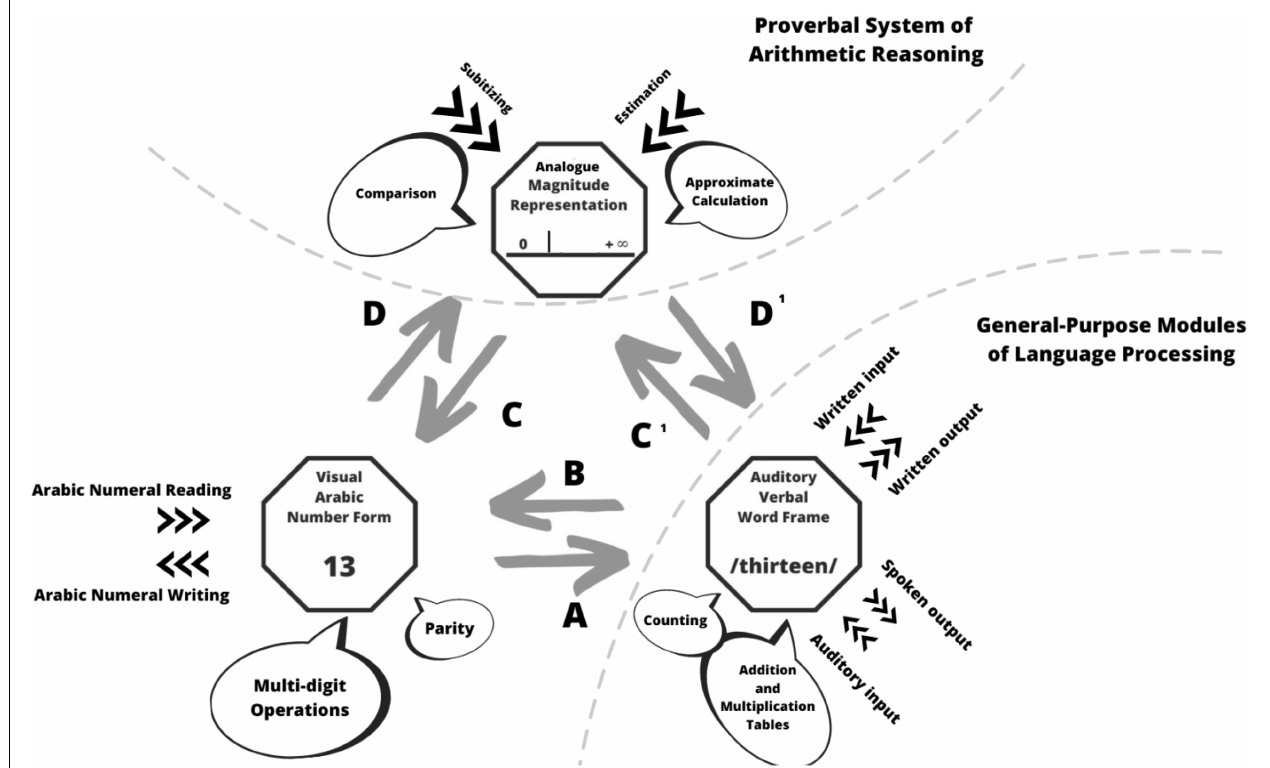
FIGURE 1 | The triple-code model (adapted from Dehaene, 1992, p.